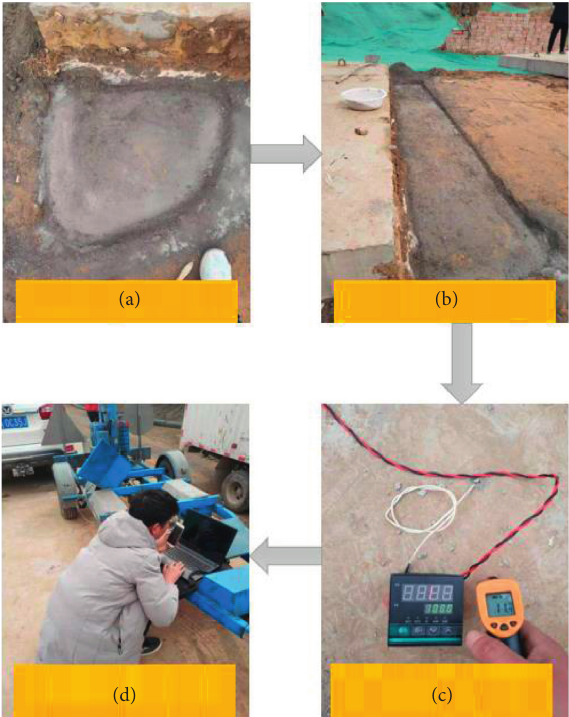
Figure 13: Flow chart of the field test. (a) Void in panel corner. (b) Void in panel edge. (c) Road surface temperature detection. (d) Detection of road surface